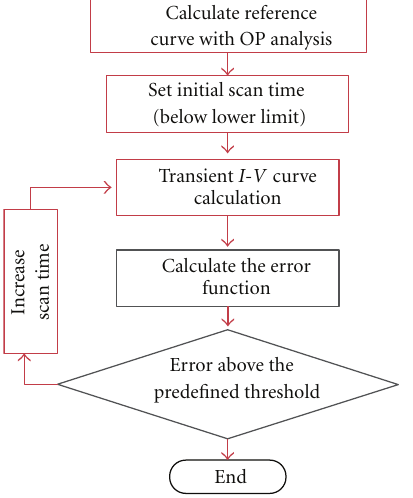
Figure 9: Scan time extraction algorithm. Figure 10: Error versus scan time for the three cells under